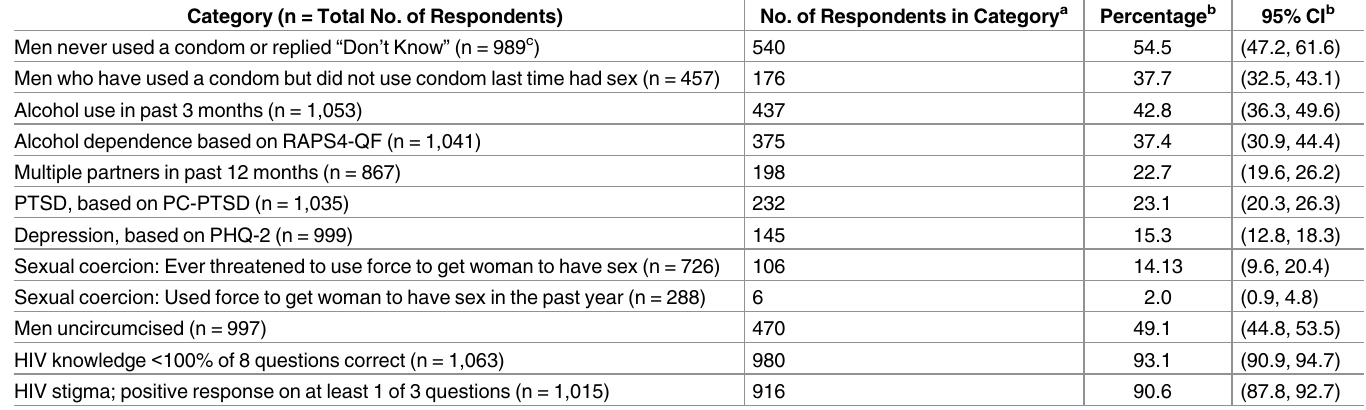
Table 4. HIV risk factors among SPLA